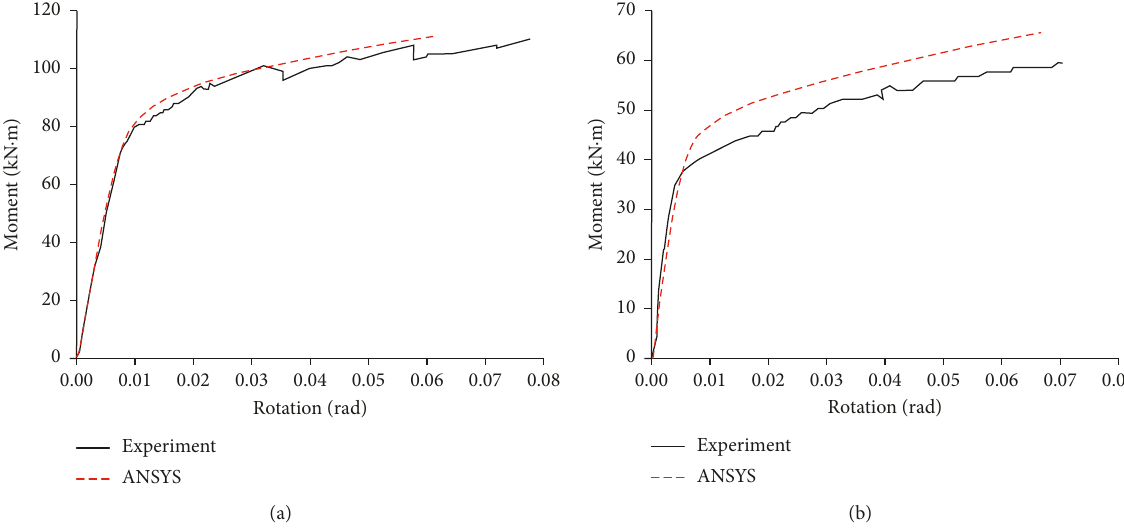
Figure 6: Comparisons of the moment-rotation curves. (a) Specimen MZ-1. (b) Specimen